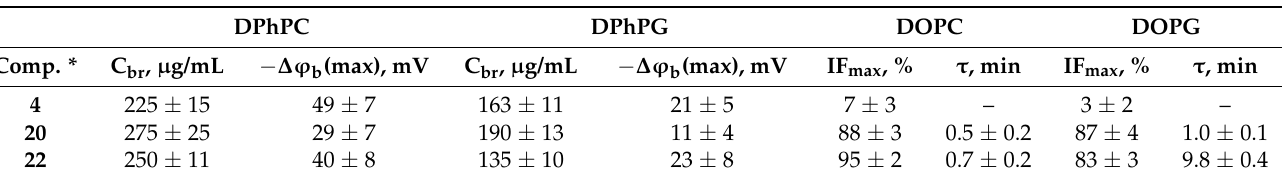
Table 4. Parameters characterizing the effects of compounds 4 , 20 , and 22 * on the model lipid membranes of various